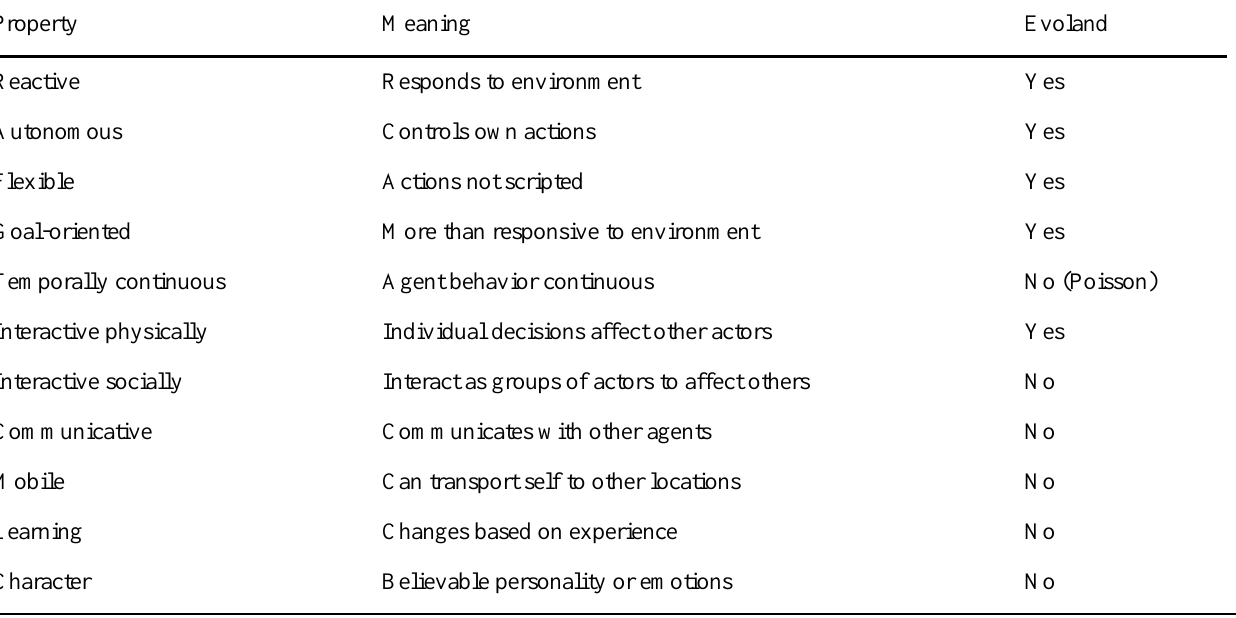
Table 1 . Characteristics of agents in Evoland compared to a comprehensive list modified from a table by Benenson and Torrens (2004:156). The temporal distribution of agent decisions in Evoland approximates a Poisson process with user-specified mean frequency (10 yr for the case